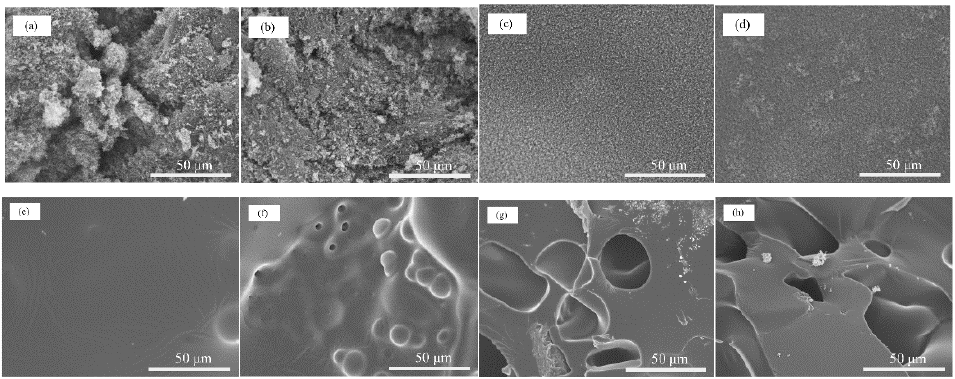
Figure 12. The SEM images of the outer ( a – d ) and the inner ( e–f ) residue chars of the pure EP ( a , e ), the EP-4% PDPG ( b , f ), the EP-2% GO-MD-MP ( c , g ), and the EP-4% GO-MD-MP ( d , h ) composites.